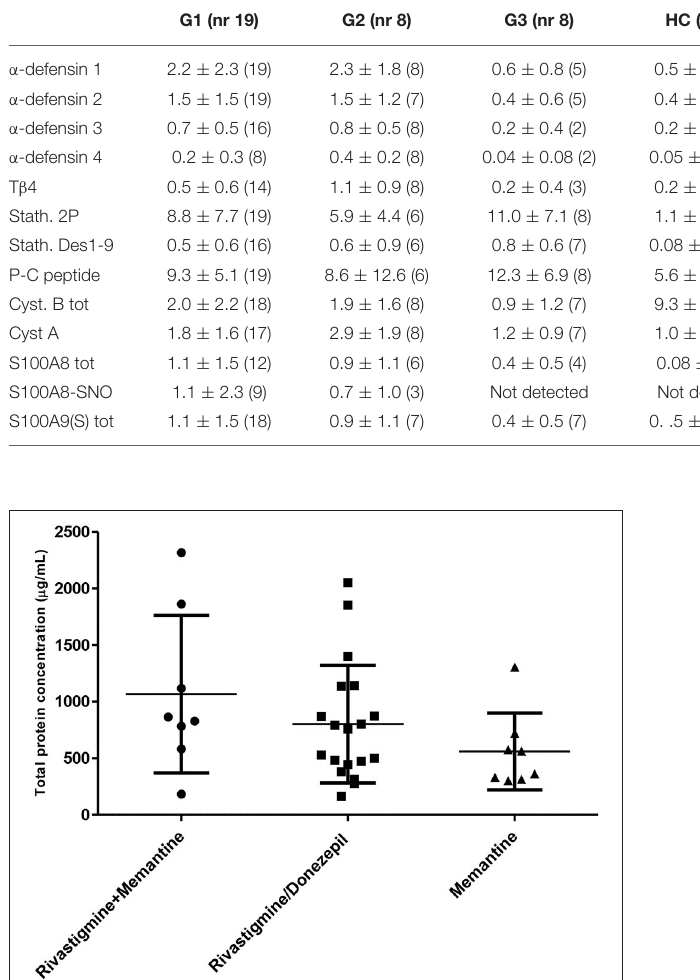
Frontiers in Neuroscience |